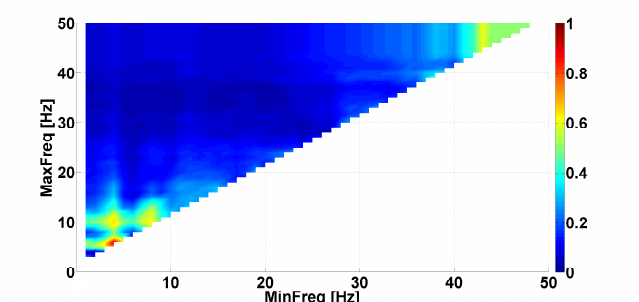
Figure 7. Example of Frequency cross-wavelet spectrum (CWS) AUC diagram. The tremor signals are analyzed in the antagonist muscles of the left arm of first-stage PD patients and ET patients. The abscissa axis is the lower bound of the frequency range; the ordinate axis is the upper bound of the frequency